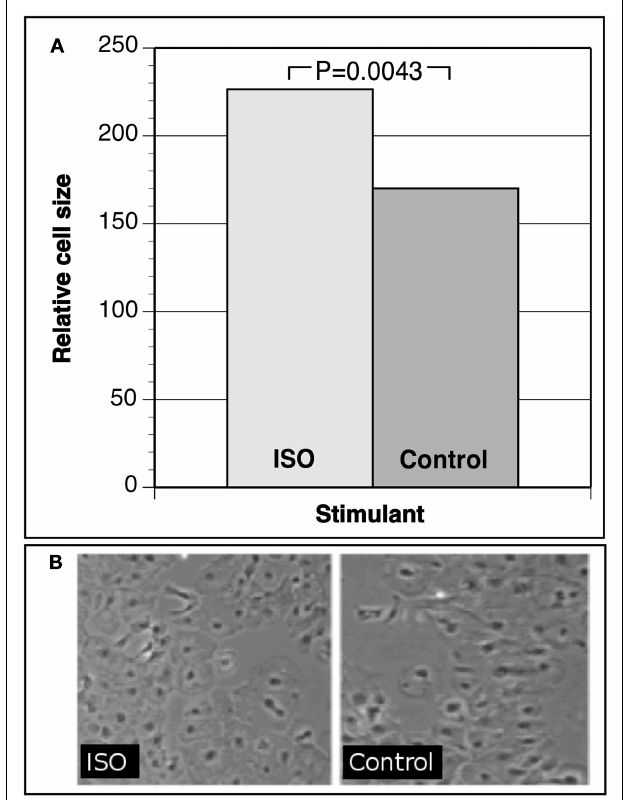
FIGURE 1 | (A) Relative cell size of iCell cardiomyocytes under isoproterenol (ISO) hypertrophic stimulation versus control cells. (B) Photographs of iCell cardiomyocytes after hypertrophic stimulation versus